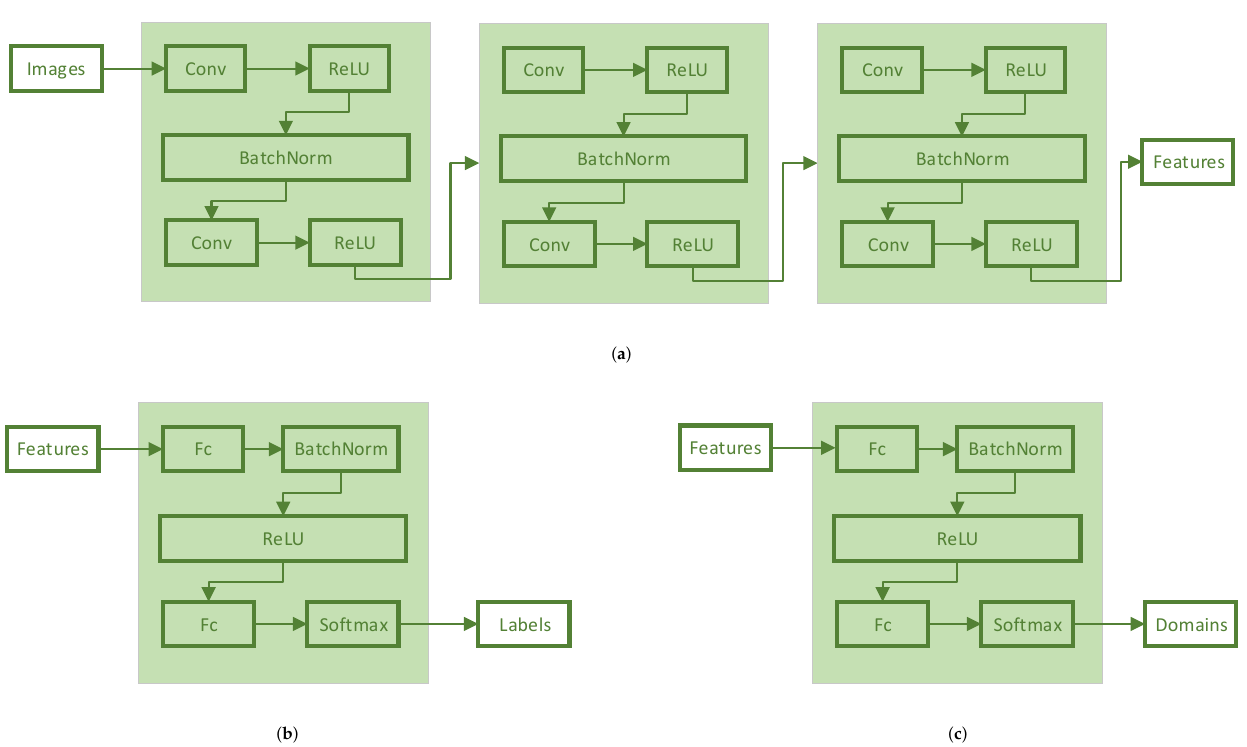
Figure 6. Network structure of the feature extractor, label classifier and domain classifier in MC- DANN. ( a ) Feature Extractor; ( b ) Label Classifier; ( c ) Domain Classifier. The pseudo-code of the proposed MCDANN training process is shown in Algorithm 1. Algorithm 1 Training process of